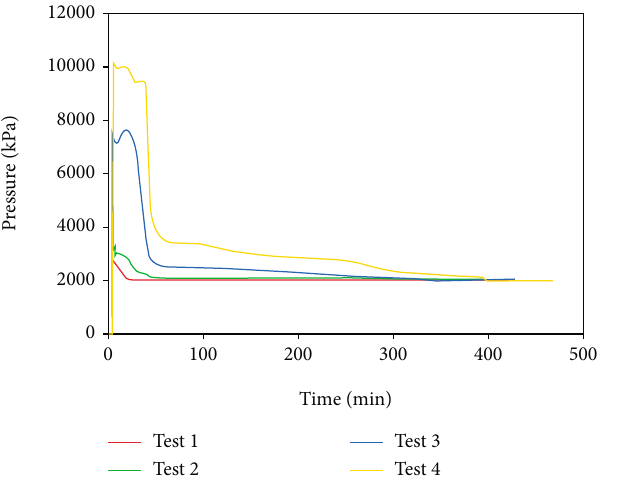
Figure 7: Flooding e ffi ciency curves.